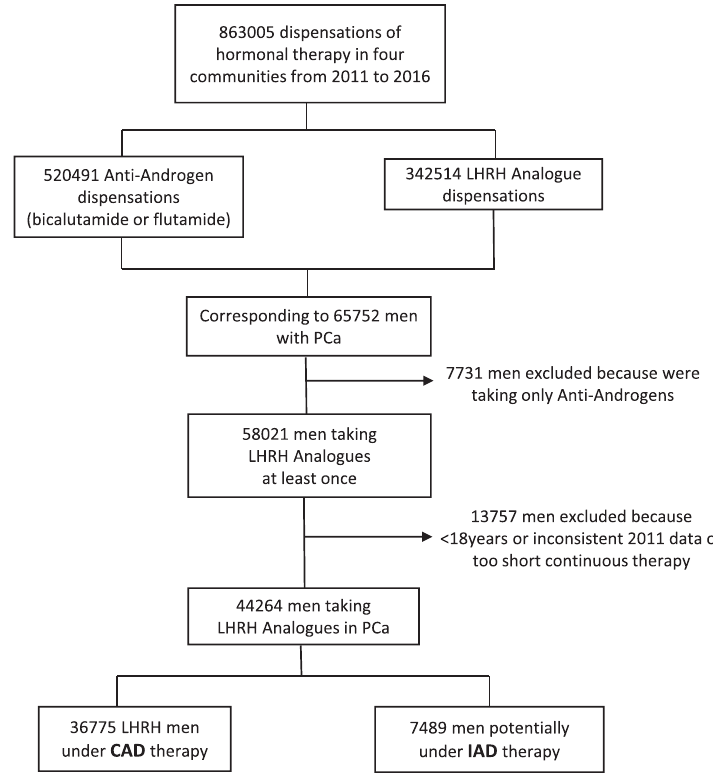
Figure 2. Patient distribution